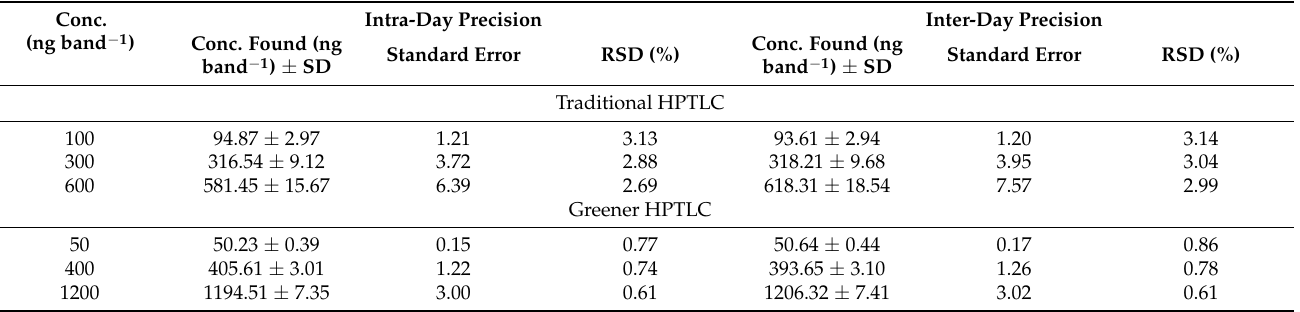
Table 4. Evaluation of VD3 intra/inter-day precision for traditional and greener HPTLC methods (mean ± SD; n = 6).